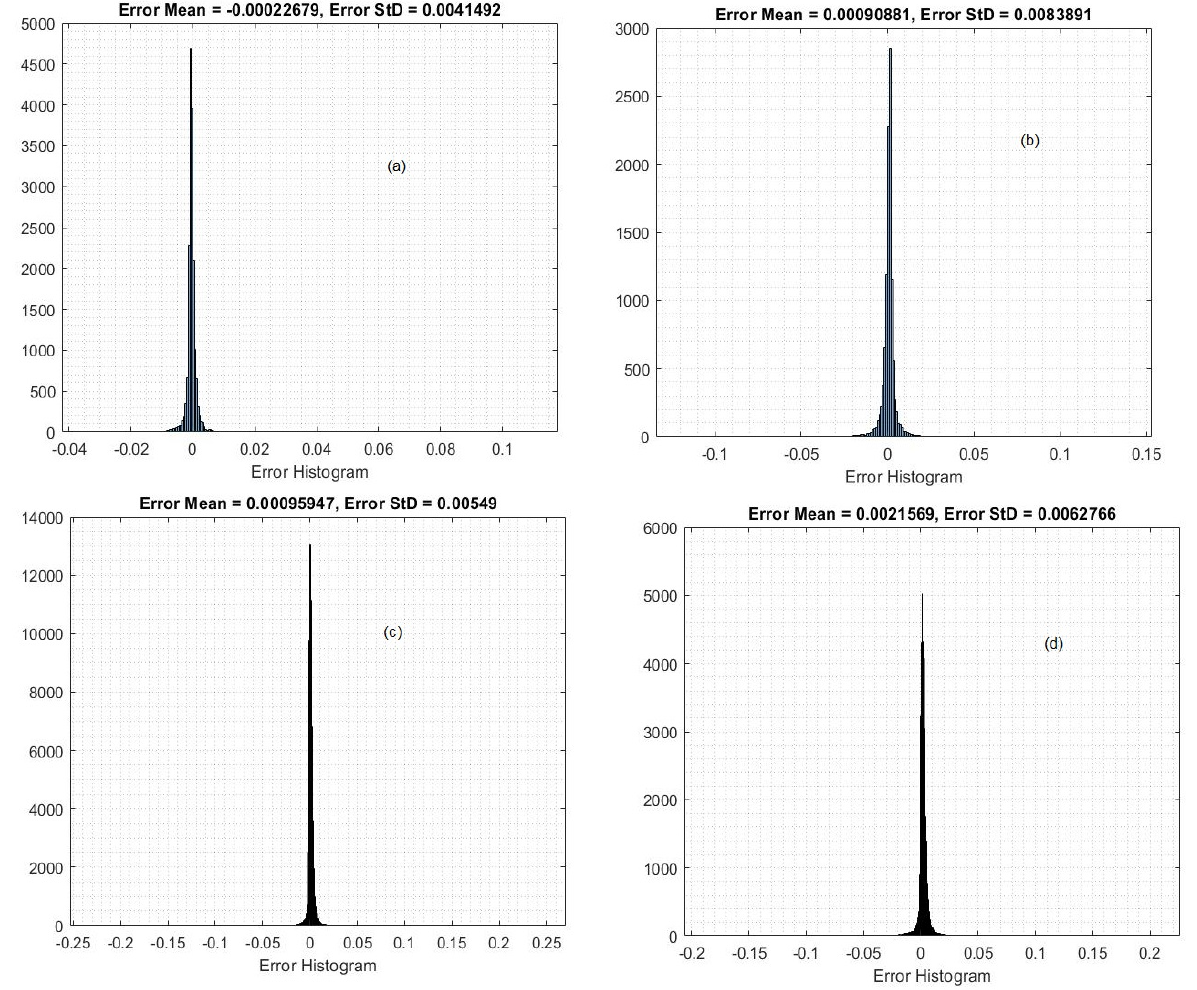
Figure 12. Histogram error of MLP in training testing ( a ) communication ( b ) energy, ( c ) financial and ( d ) industrial sectors.